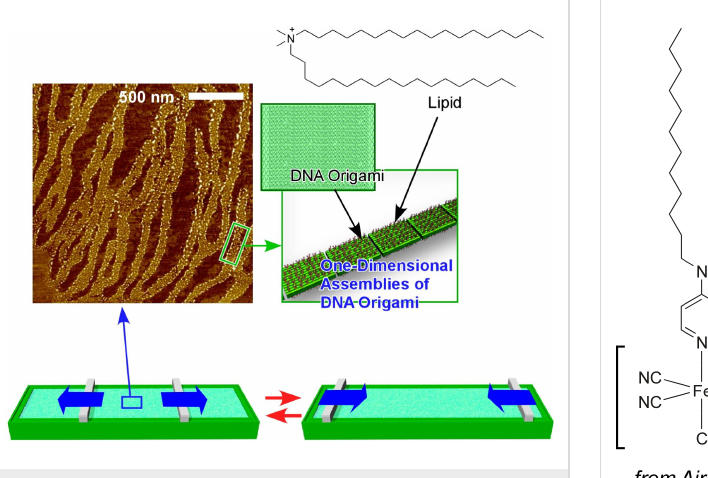
Figure 8: Formation of one-dimensional supramolecular polymeriza- tion of DNA origami pieces upon repeated mechanical compressions and expansions of two-dimensional air-water interface. An AFM image was reprinted with permission from [144], copyright 2019 American Chemical Society.